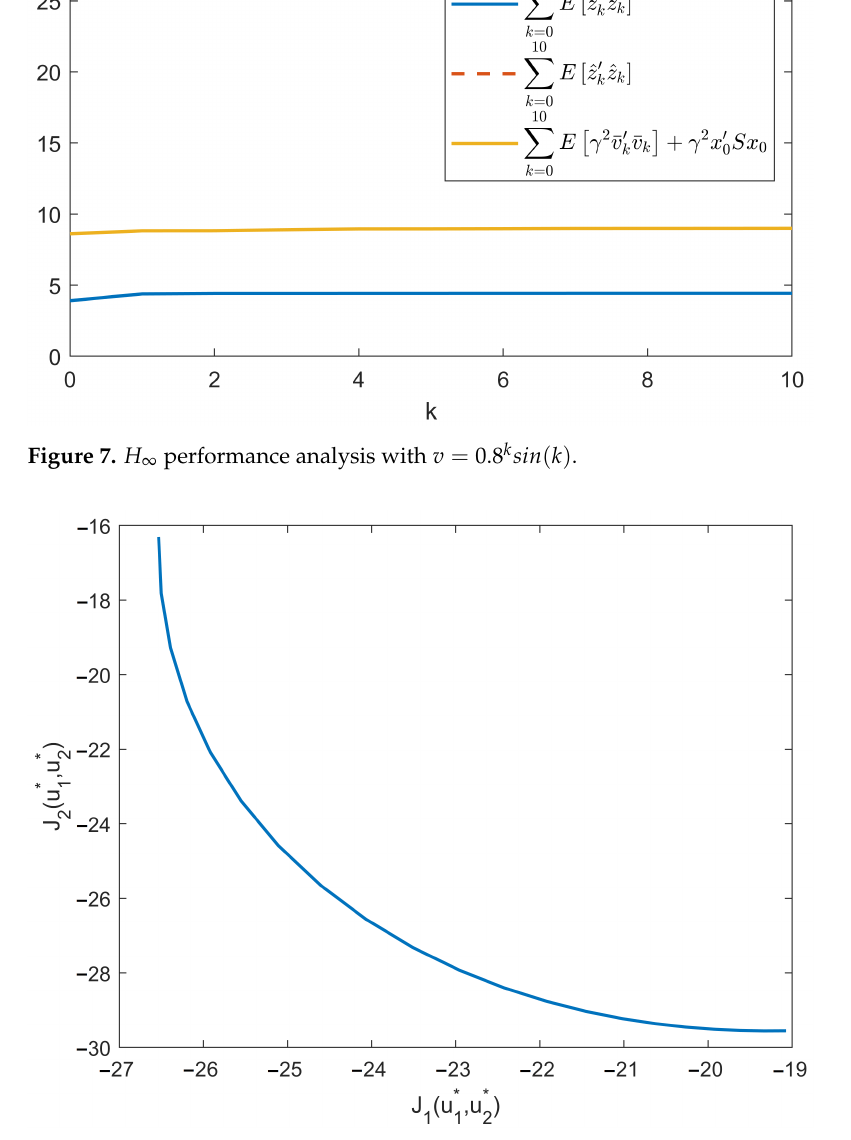
Figure 8. Pareto